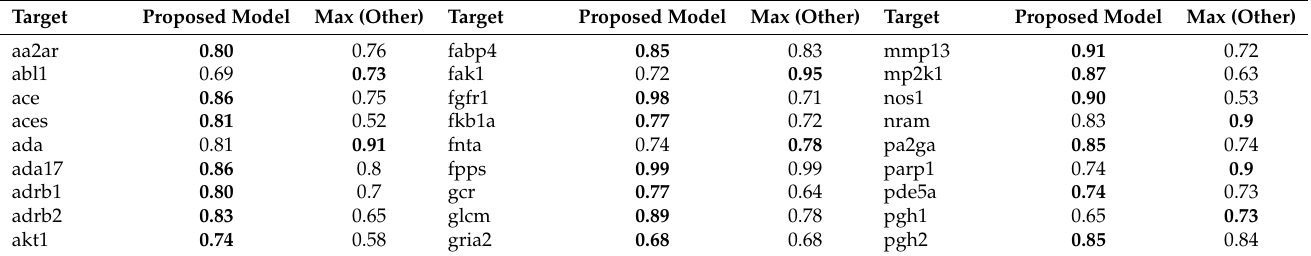
Table 4. Per target comparison of the current SC implementation versus state-of-the-art models. Data taken from [57]. Target Proposed Model Max (Other)